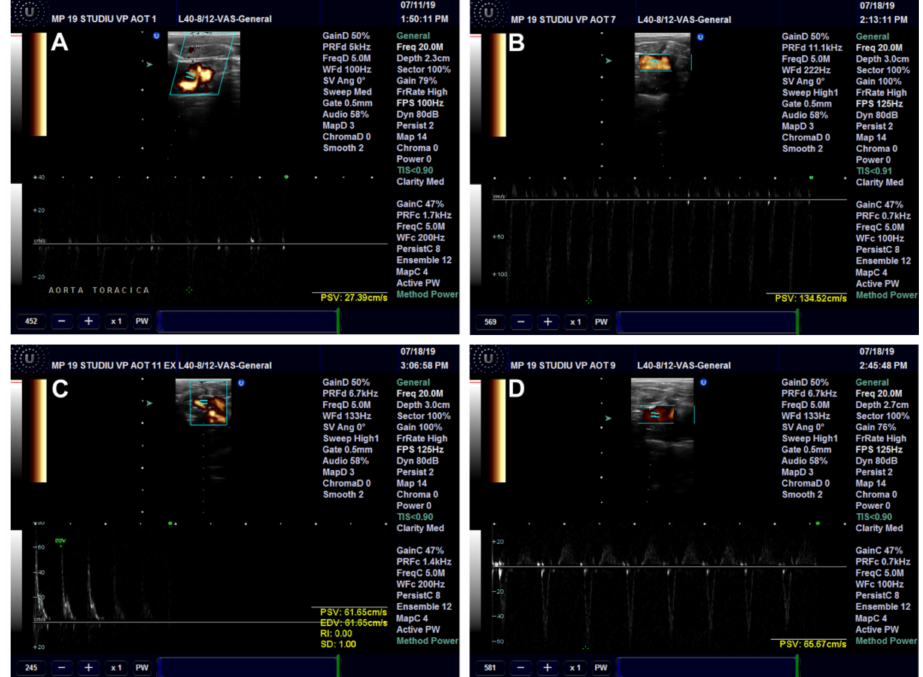
Figure 12. Descending aorta blood flow in rats with 9 months of HFD, the last month with oral administration of: 0.9% saline solution for Control ( A ) and HFD ( B ) groups, Cornus mas L. extract for HFD + CM group ( C ) and gold nanoparticles functionalized with bioactive compounds from Cornus mas L. extract for HFD + AuNPsCM group ( D